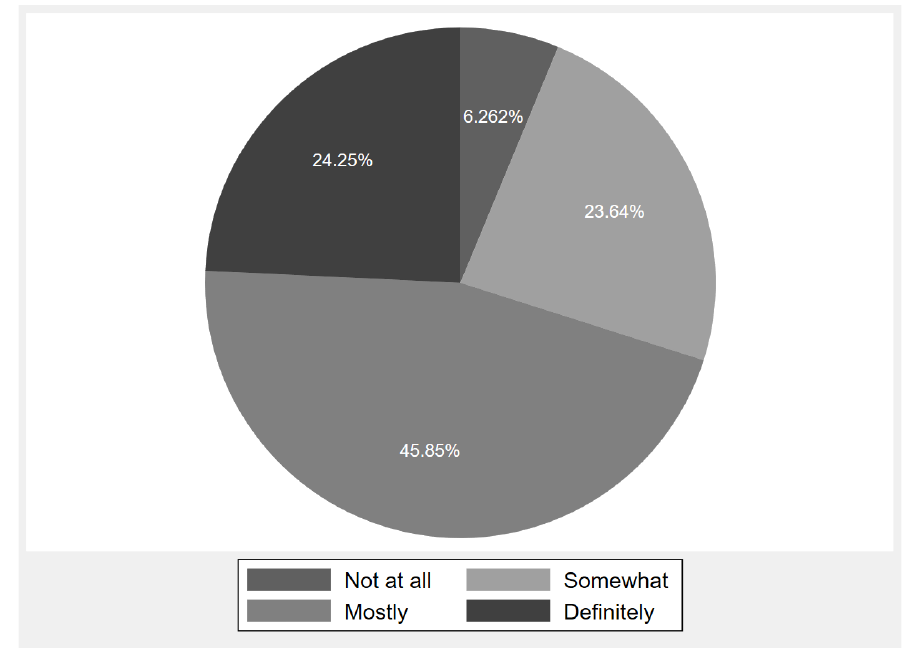
Figure 2. Percentage of patients who can easily obtain chronic disease management services at a nearby primary care facility.